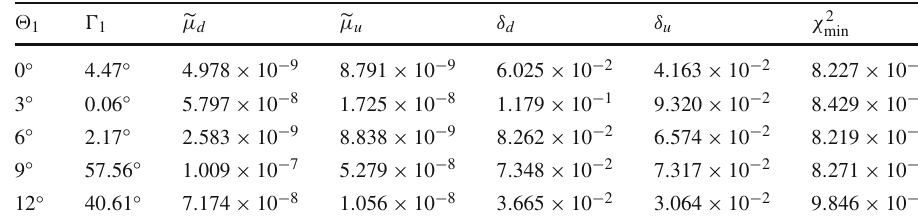
Table 1 Numerical values obtained for the six parameters as a χ 2 function at BFP. These results were obtained by considering simultaneously to free parameters in the scan of the parameter